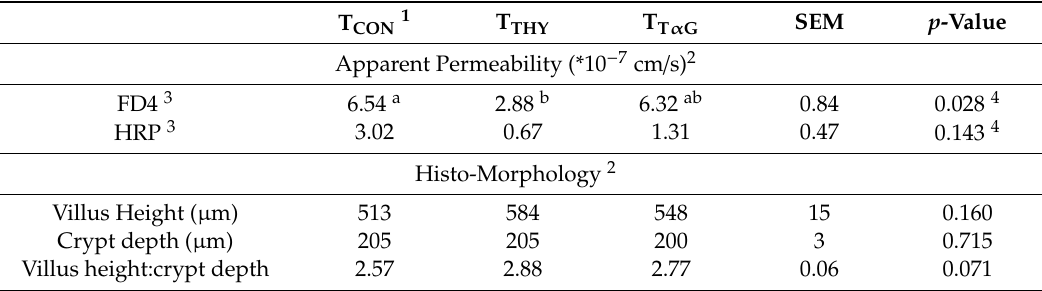
Table 3. The e ff ect of dietary treatment on barrier function and histo-morphology in the distal jejunum of piglets between 13 and 15 days post-weaning. T CON 1 T THY T T α G SEM p -Value Apparent Permeability (*10 − 7 cm / s)